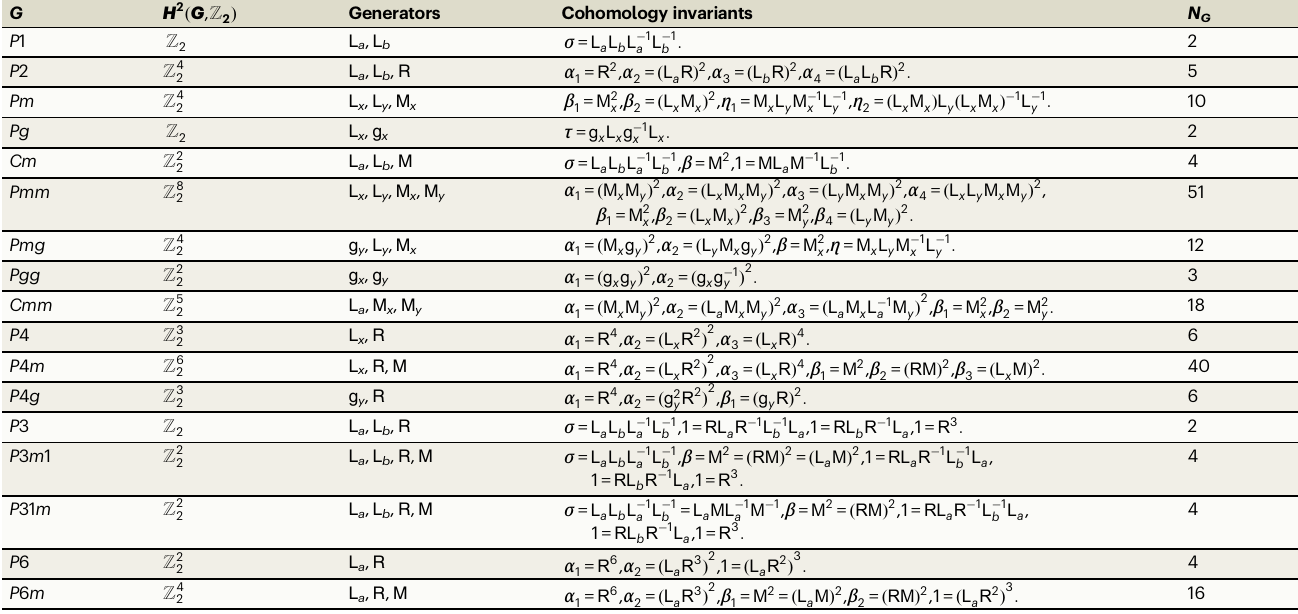
The fi rstcolumn ‘ G ’ liststhenamesof17wallpapergroups,andthesecondcolumn ‘ H 2 ð G , Z 2 Þ ’ presentsthecorrespondingsecondcohomologygroups.Thechosengeneratorsofeachwallpaper grouparegiveninthethirdcolumn.ThePSAsandthecohomologyinvariantsarepresentedinthefourthcolumn. L , R , M and g denotetranslation,rotation,mirrorandglidere fl ection,respectively. σ , α , β , η and τ are the fi ve classes of cohomology invariants valued in Z ‘ N G ’ liststhe number of equivalence classesofPSAs foreachwallpaper 2 = f ± 1 g . The lastcolumn